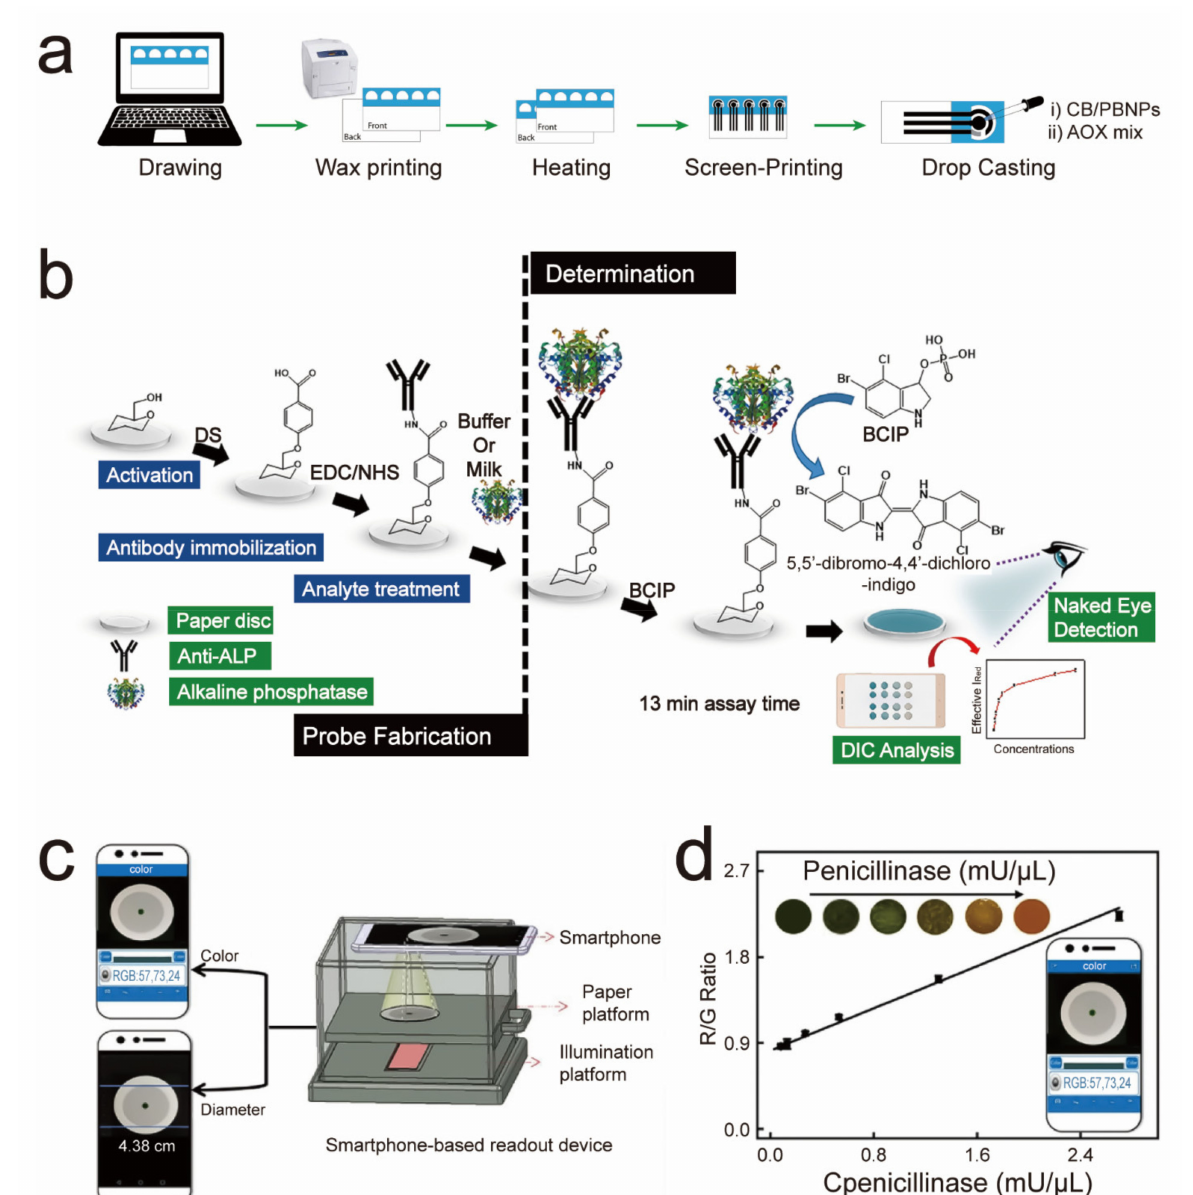
Figure 4. Paper-based sensors for food safety testing. ( a ) Fabrication processes of the biosensor that aimed for ethanol sensing in beer samples. Reprinted/Adapted with permission from Ref. [31]. Copyright 2017 Elsevier B.V. ( b ) Synthesis and working principles of the ALP-sensing device. Reprinted/Adapted with permission from Ref. [32]. Copyright 2019 Elsevier B.V. ( c ) Diameter- and color-based dual-signal readouts of the penicillinase sensor. ( d ) Color-based detection of penicillinase based on the pH-sensitive color change of Alg-CTAB-BTB. Reprinted/Adapted with permission from Ref. [69]. Copyright 2021 Elsevier